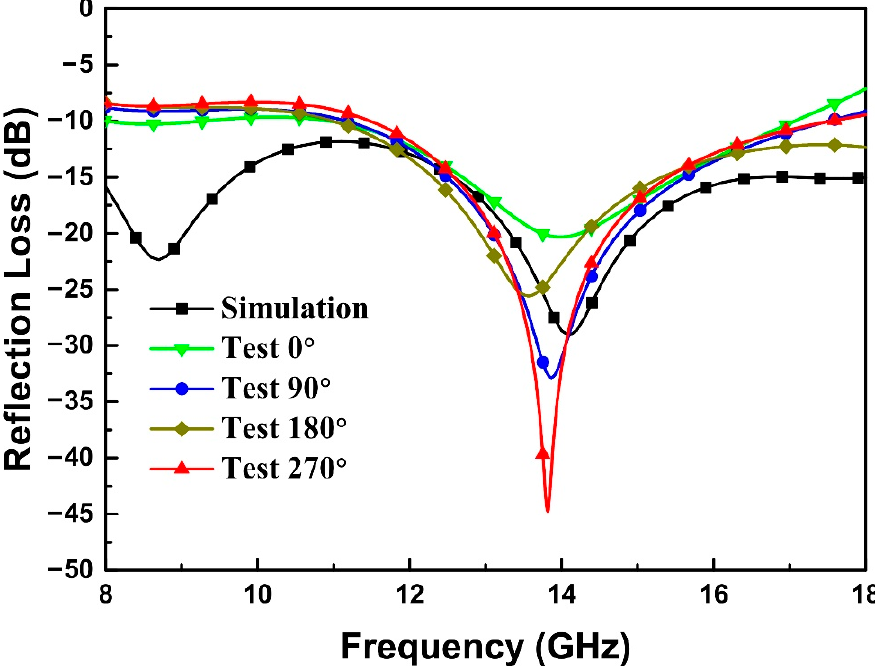
Figure 3. Normal experimental reflectivity of gradient honeycomb metastructure shown in Figure 2h, i in X and Ku bands from four directions in comparison with the simulated result.